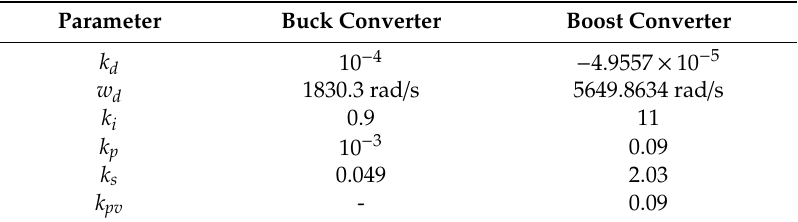
Table 5. Control design